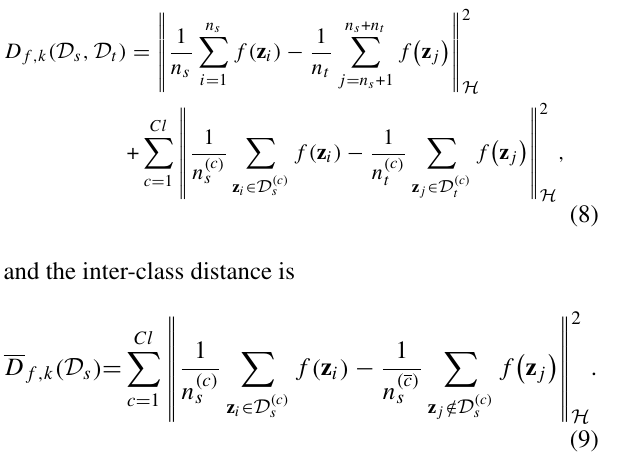
Problem solving and algorithm